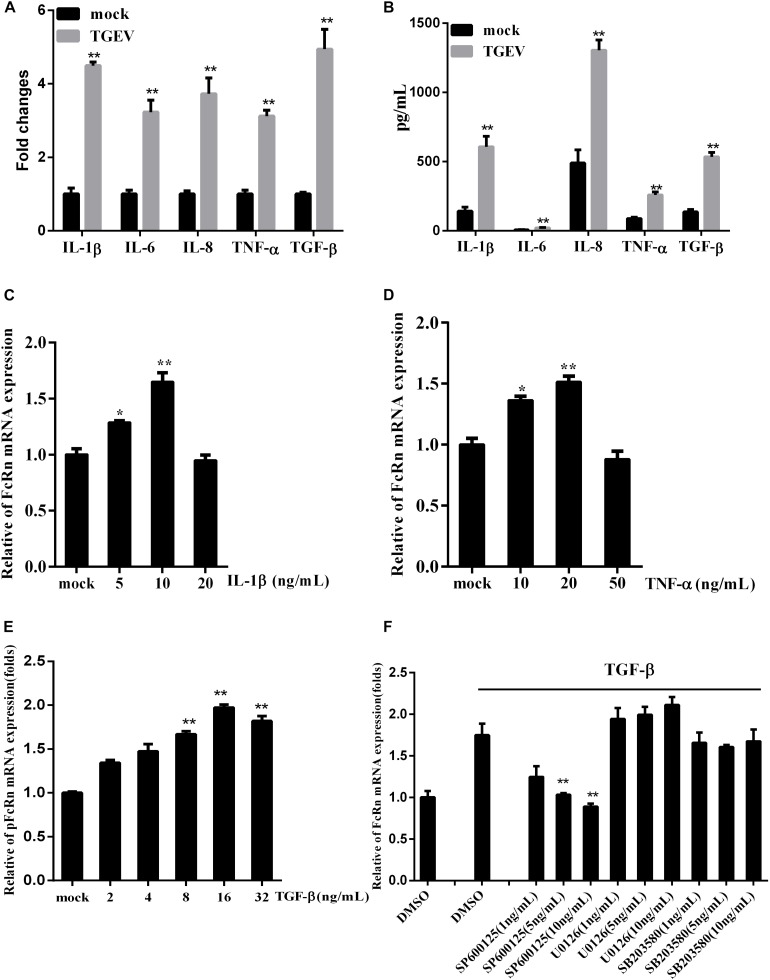
Regulation of FcRn mRNA on IPEC-J2 cells stimulated by TGF-β. (A,B) The relative mRNA and protein levels of IL-1β, IL-6, IL-8, TNF-α, and TGF-β in IPEC-J2 infected with TGEV for 36 hpi by RT-PCR and porcine cytokine array. (C–E) IPEC-J2 cells were stimulated with TNF-α, IL-1β, TGF-β for 2 h, and the levels of FcRn mRNA were detected using RT-qPCR. (F) IPEC-J2 cells were pretreated with SB202190 (1, 5, and 10 ng/mL), SP600125 (1, 5, and 10 ng/mL), or U0126 (1, 5, and 10 ng/mL) or DMSO (control) for 2 h, followed by with/without TGF-β for 2 h and the levels of FcRn mRNA were detected using RT-qPCR. ∗p < 0.05, ∗∗p < 0.01.